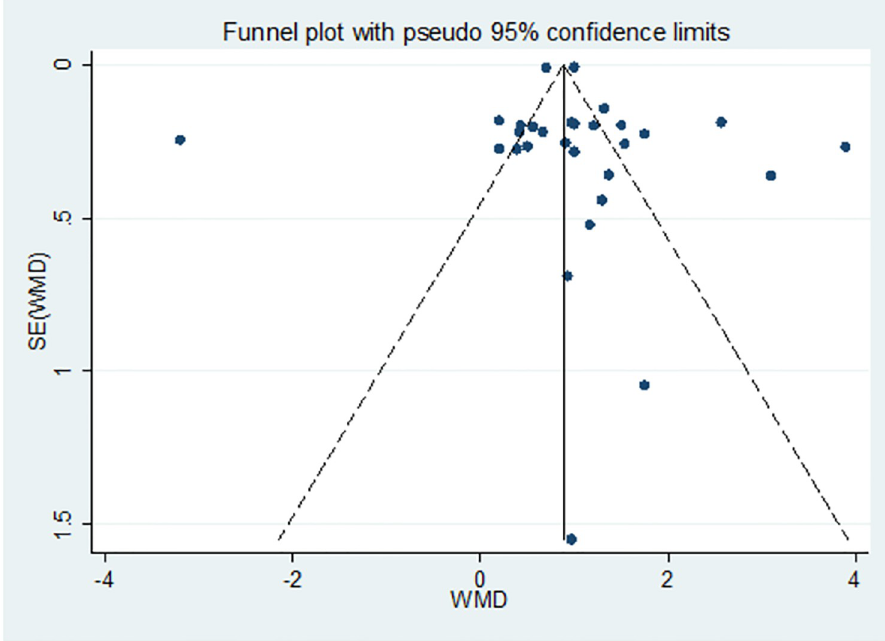
Fig 5. Funnel plot for the pooled WMD estimate of MPV between PE and NT groups.